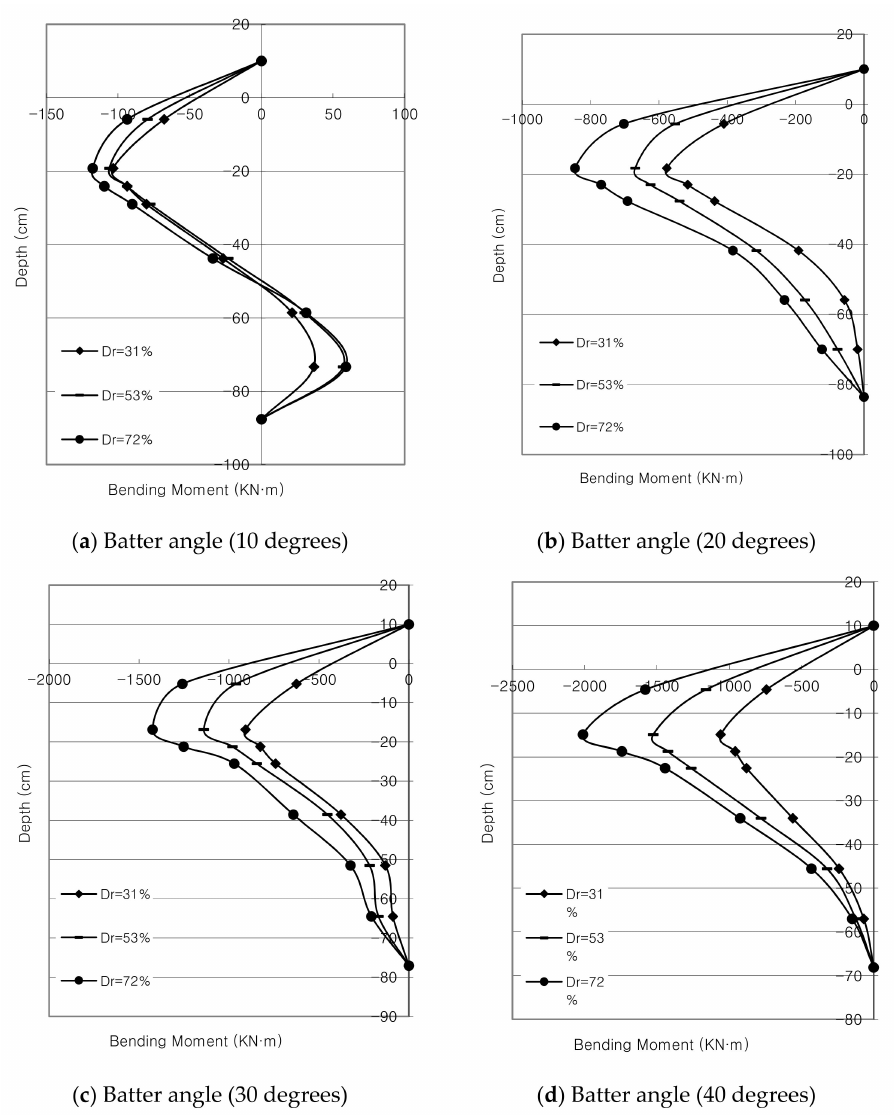
Figure 13. Relation of the relative density and bending moment at Vertical Displacement of 1